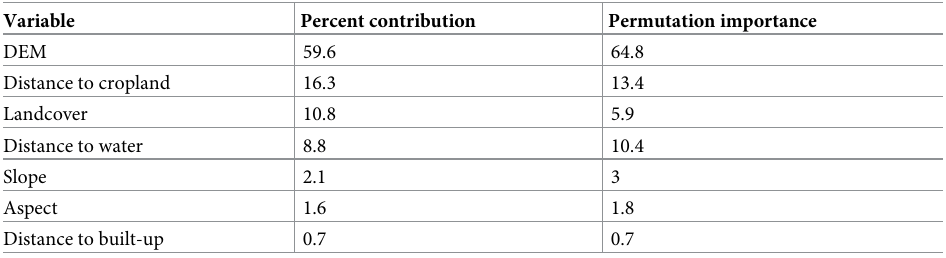
Table 2. Environmental variable contribution percent and permutation importance used for water deer habitat suitability modelling. Based on 99 distribution locations in Northeast China and the Russian Far